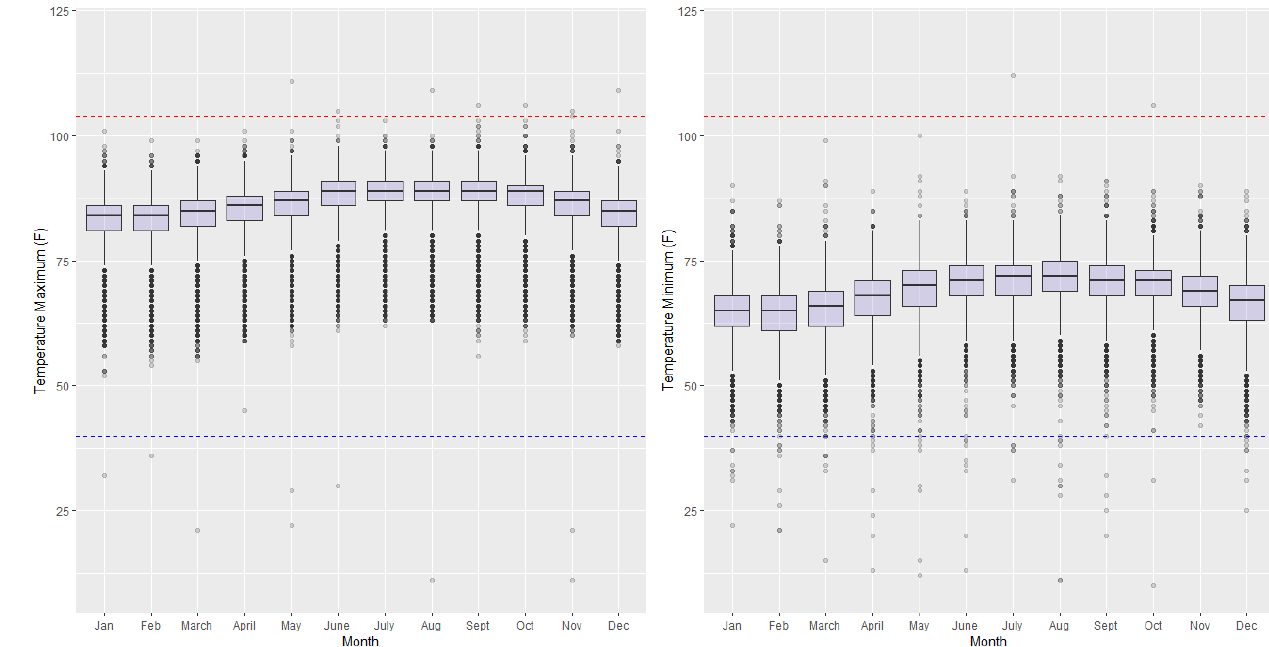
Figure 2. TMAX (left) and TMIN (right) seasonal temperature boxplots for all 23 GHCN stations along with the NWS San Juan maximum and minimum observed temperature extrema (red and blue lines, respectively). This figure was created using Wickham (2016).